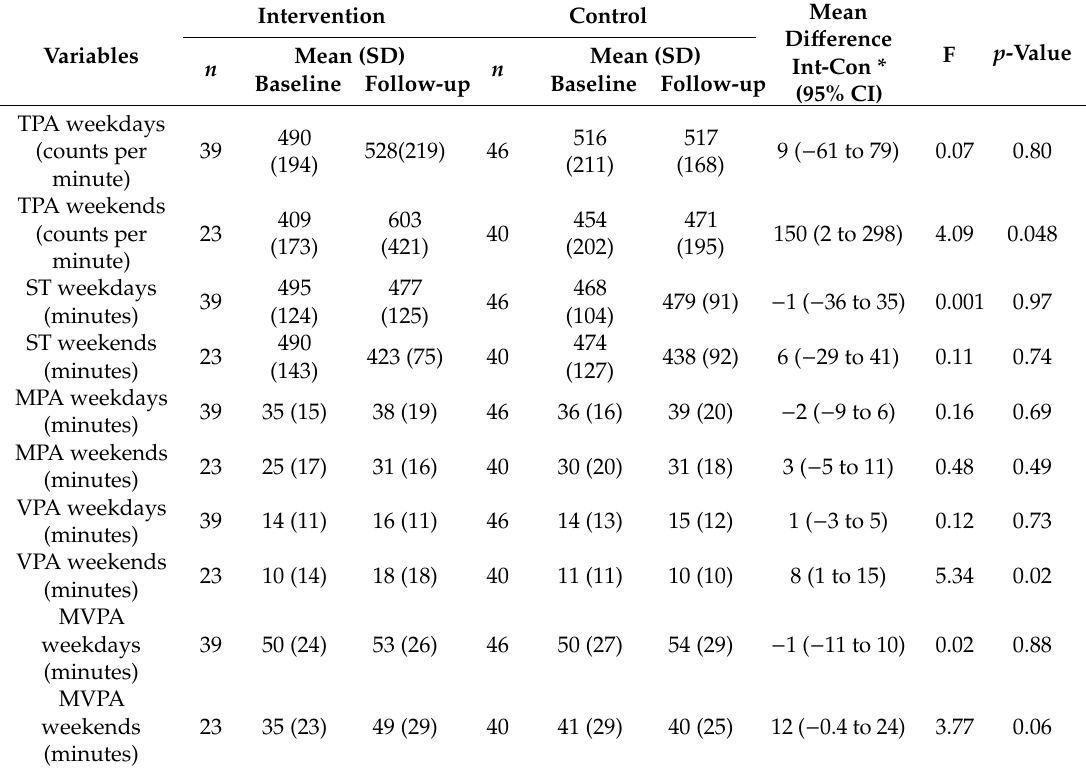
Table 2. Di ff erences between intervention and control groups in physical activity and sedentary time.